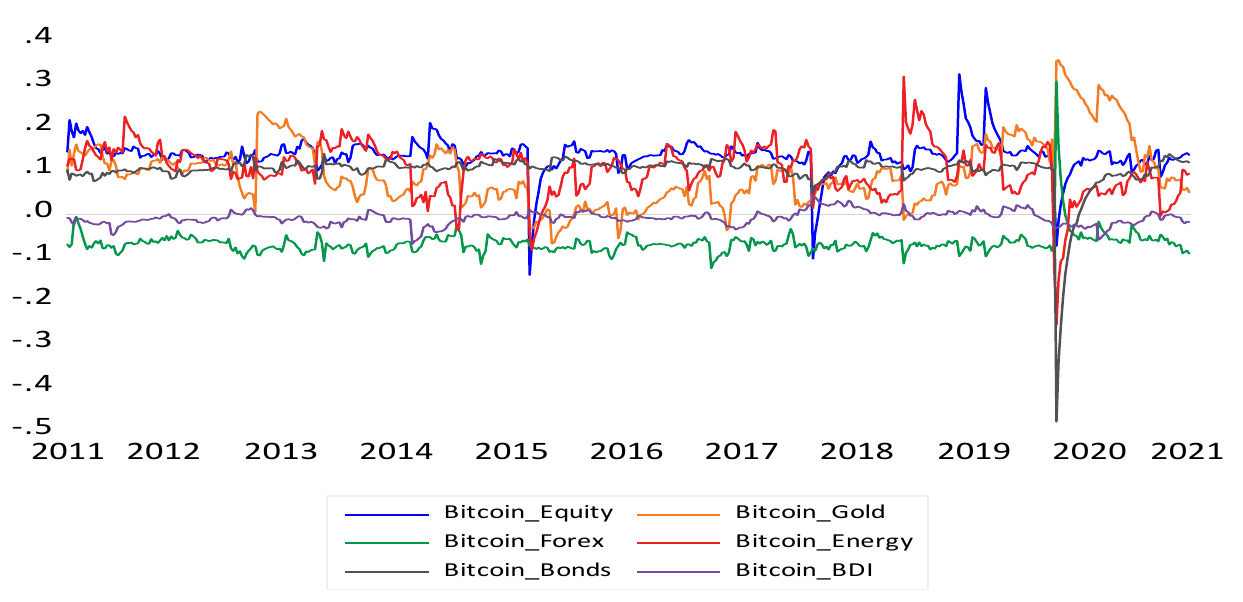
Figure A1. Dynamic conditional correlation—Bitcoin with all assets (DCC-GARCH). Note: The graph in Figure A1 suggests that Bitcoin exhibits a negative conditional correlation with Forex and BDI, while it exhibits a very low correlation with other assets throughout the sample period. The conditional correlation appears to sharply fluctuate (dip) during the periods of financial crisis (for instance, the COVID-19 crisis in early 2020), thereby suggesting some potential of Bitcoin as a hedge or safe haven against those assets.